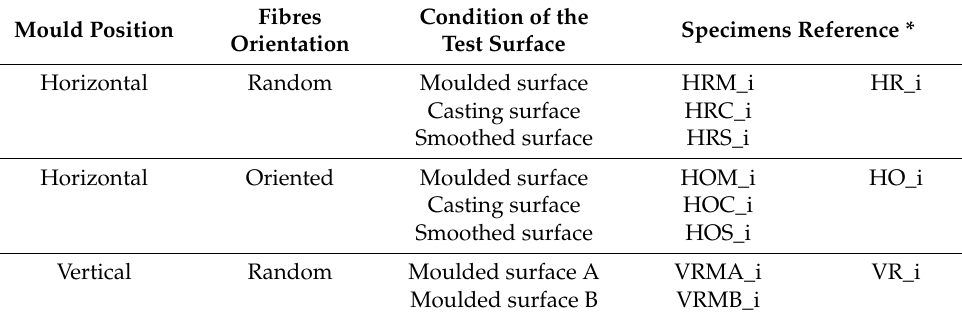
Figure 8. ( a ) Process of polishing the casting surface; ( b ) Surface after polishing. Table 4. Referencing of specimens from test series